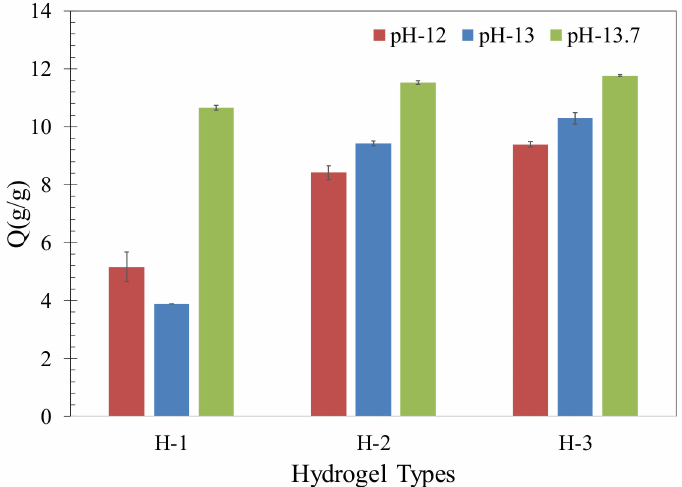
Figure 1. Absorption of the different hydrogels in synthetic pore solutions with varied pH values.